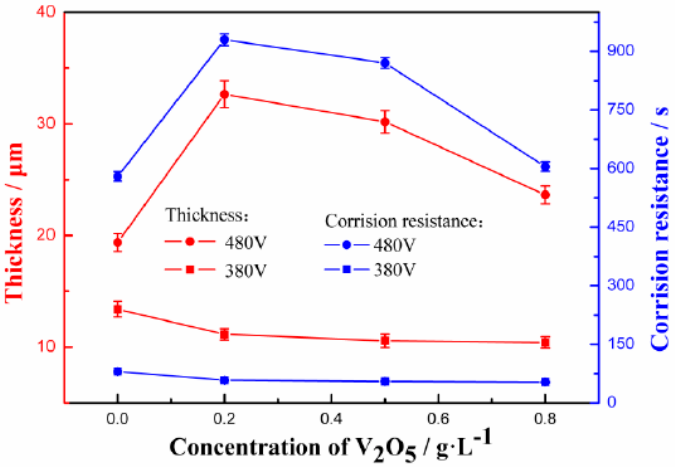
Figure 8. Effect of V 2 O 5 on thickness and spotting corrosion resistances of coatings.